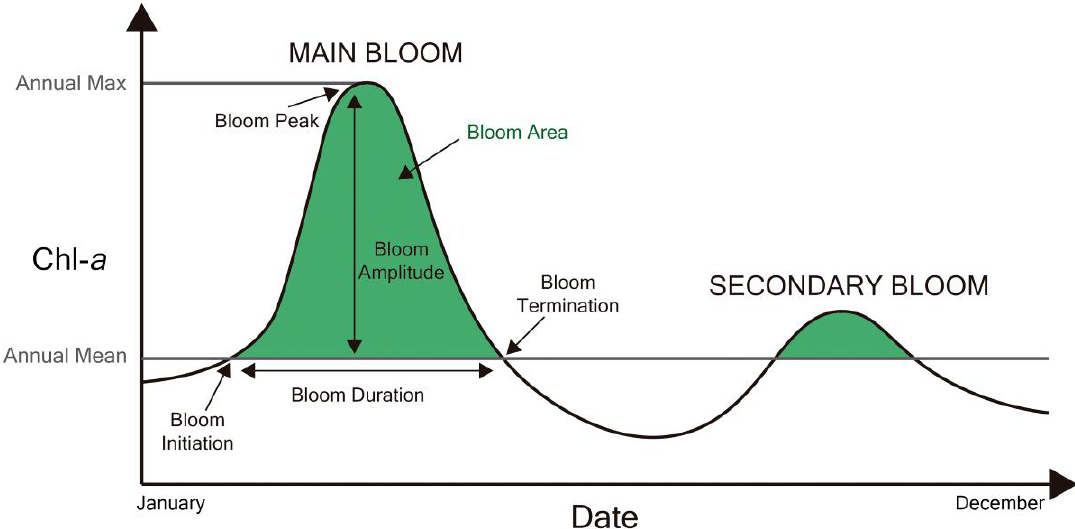
Figure 2. Representation of phytoplankton bloom phenology metrics calculated in this work: chl- a mean, chl- a max, bloom amplitude, days of bloom initiation and termination, bloom duration, day of bloom peak, and bloom area (green). Bloom frequency and yearly area are not shown.